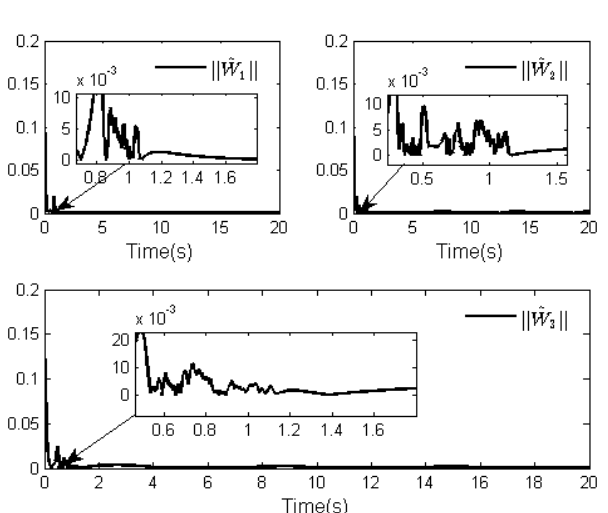
Figure 5. Norms of adaptive laws